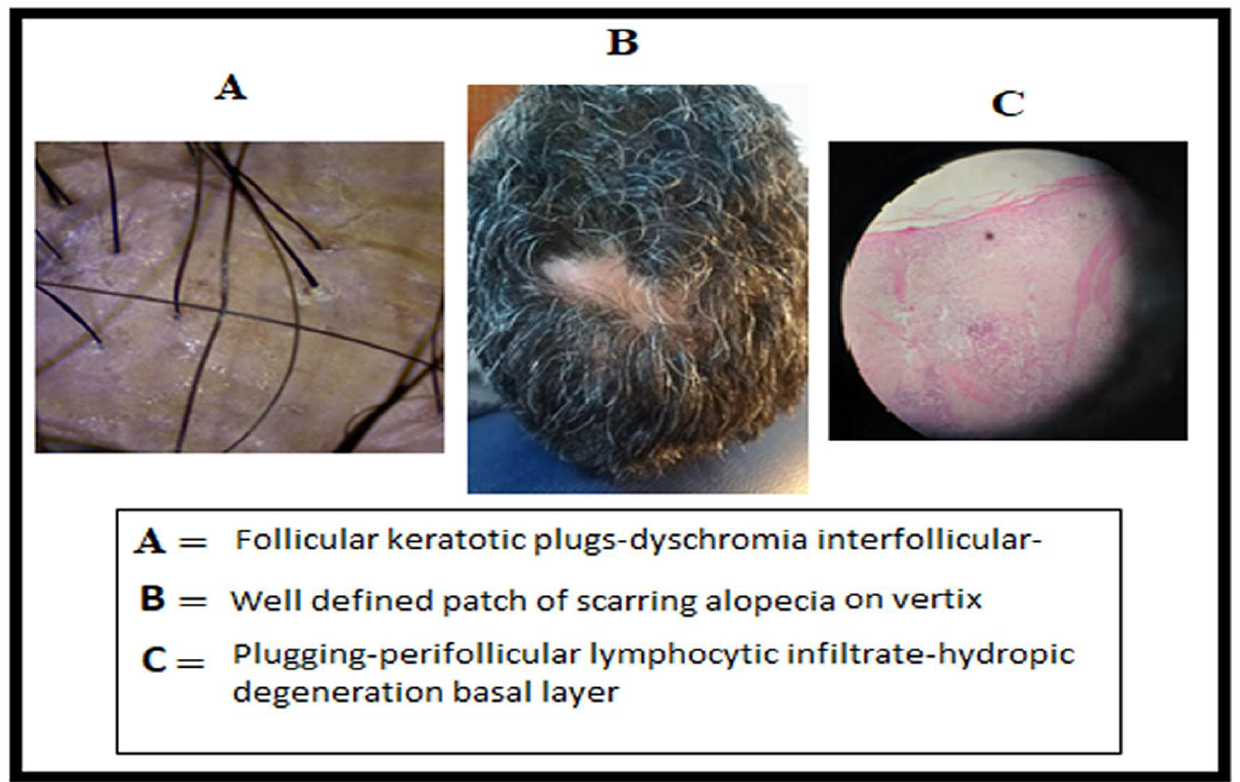
Figure 1: Clinicopathological and trichoscopic features of discoid lupus